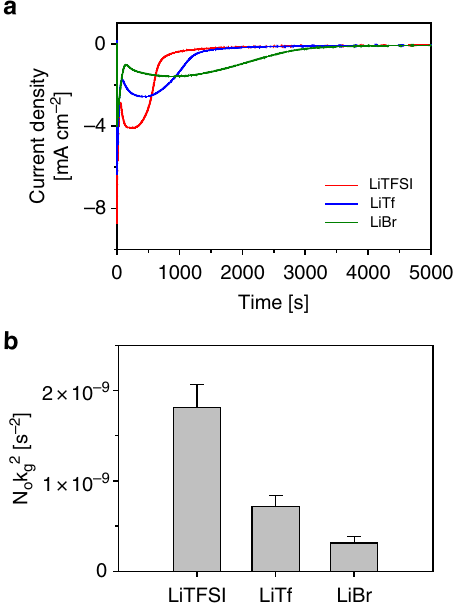
Fig. 4 Chronoamperometry analysis on electrodeposition behaviors of lithium sul fi de. a Current vs. time curves for potentiostatic electrodepositions of 1 M LiX, X = bistri fl imide (TFSI − ), tri fl ate (Tf − ), or bromide (Br − ), and 0.2 M lithium polysul fi de (LiPS) catholytes using carbon nanotube (CNT) electrodes. b The lateral growth rate constants ( N 0 k g 2 )